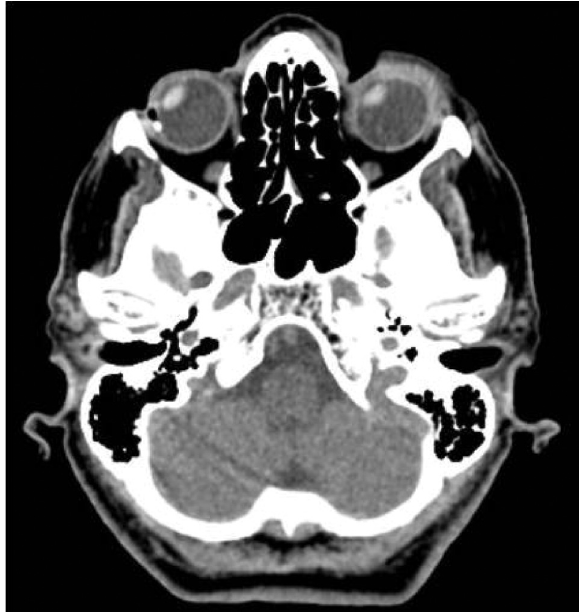
Figure 1. Non-contrast computed tomography (CT) scan showing conjugate eye deviation to the right side.